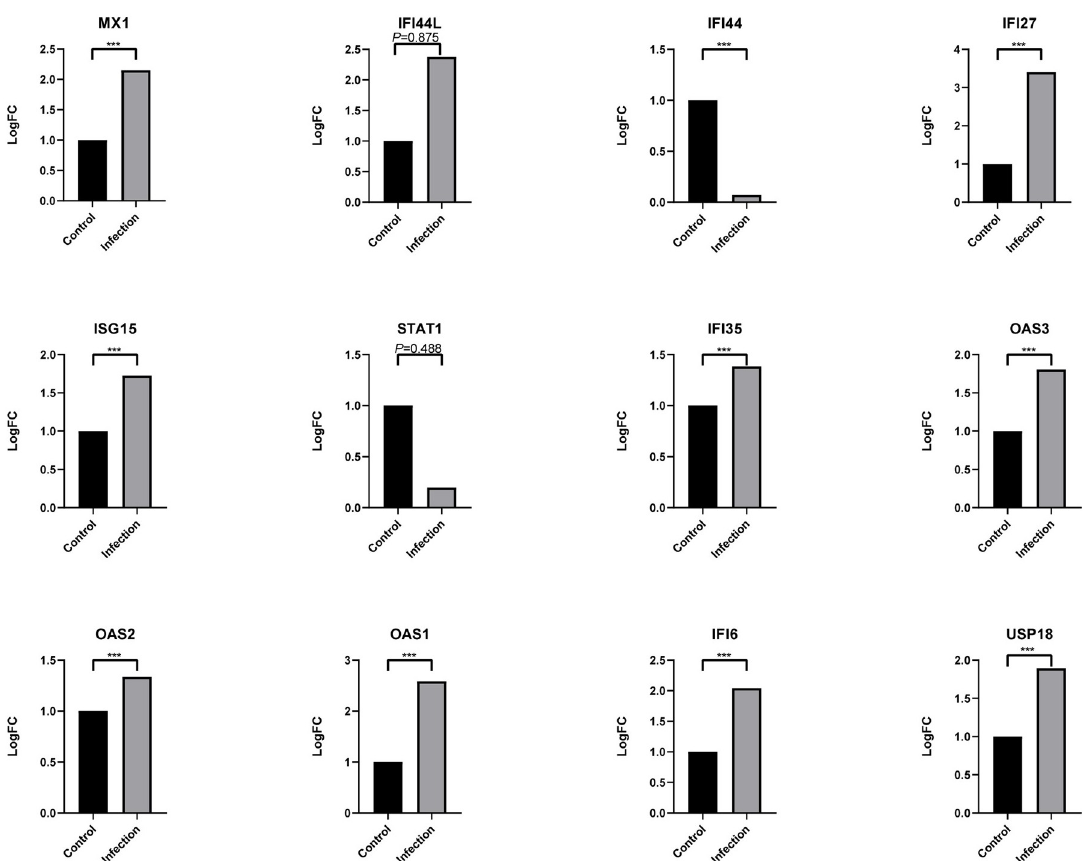
Fig 7. Verification of hub genes. P -value < 0.01 is considered to be statistically significant. ( ��� P < 0.001). https://doi.org/10.1371/journal.pntd.0009633.g007 metabolism and autophagy to inhibit viral replication and metabolism[46]. Cyclin G-associ- ated kinases (GAK) phosphorylated adaptor protein complexes (APs), thereby regulating membrane transport and promoting the dengue virus infection[47]. GAK inhibitors and their derivatives showed antiviral activity against the dengue virus[48]. XuM et al. found that the